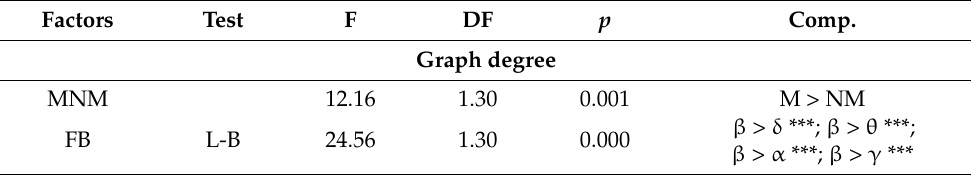
Figure 6. As in Figure 5 but for the density of the EEG graph. 3.3.2. Efficiency Indices of the Internode Communication of the EEG Graph In Table 2, the MANOVA results are shown for the normalized (vs. random net- work) local efficiency (NLE) and for the normalized (vs. random network) global effi- ciency (NGE) and in Figures 5 and 6 are shown the indices mean values for the two groups (NM and M), three conditions (T, A, and N) and five FBs. Table 2 structure and